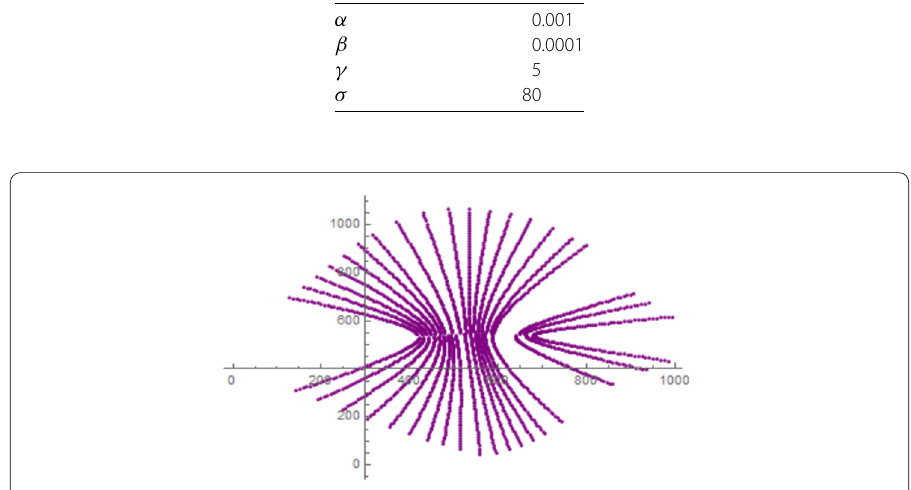
Figure 11 Reconstructed tunnel map with default